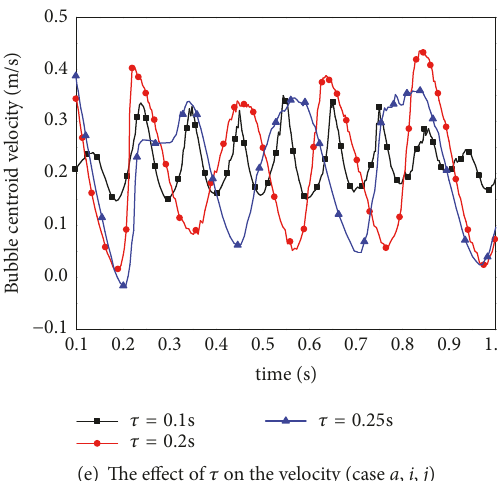
(c) The effect of 𝑈 on the velocity (case a , 𝑔 , h ) (d) The effect of Δ𝑈/𝑈 on the velocity (case k - o )